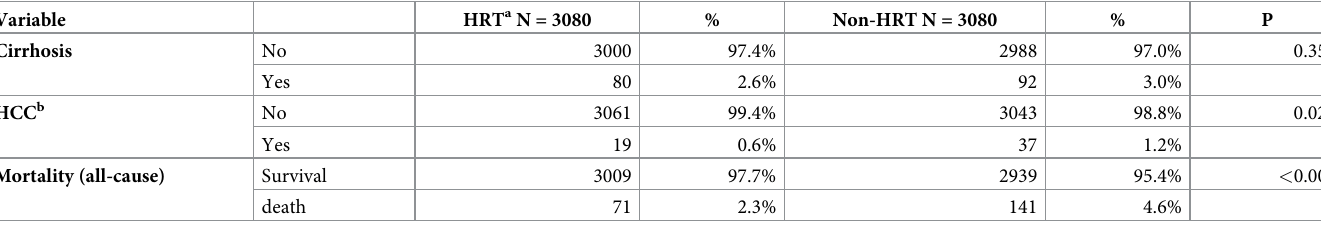
We stratified the participants into three groups based on exposure duration to determine the associations between HRT and the risks of liver cirrhosis, HCC, and all-cause mortality. For the liver cirrhosis, HCC, and all-cause mortality risks, the adjusted HRs (95% CIs) for Table 2. Outcomes of patients in the Hormone Replacement Therapy (HRT) and non-HRT cohorts.